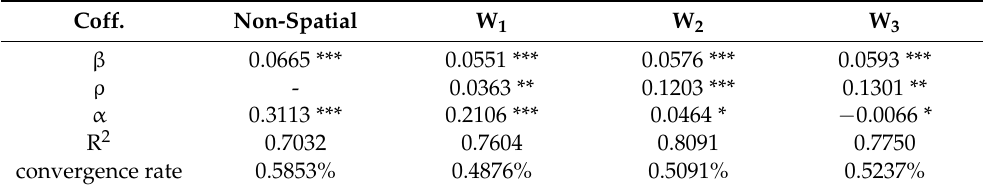
Table 1. Absolute convergence of natural gas consumption.